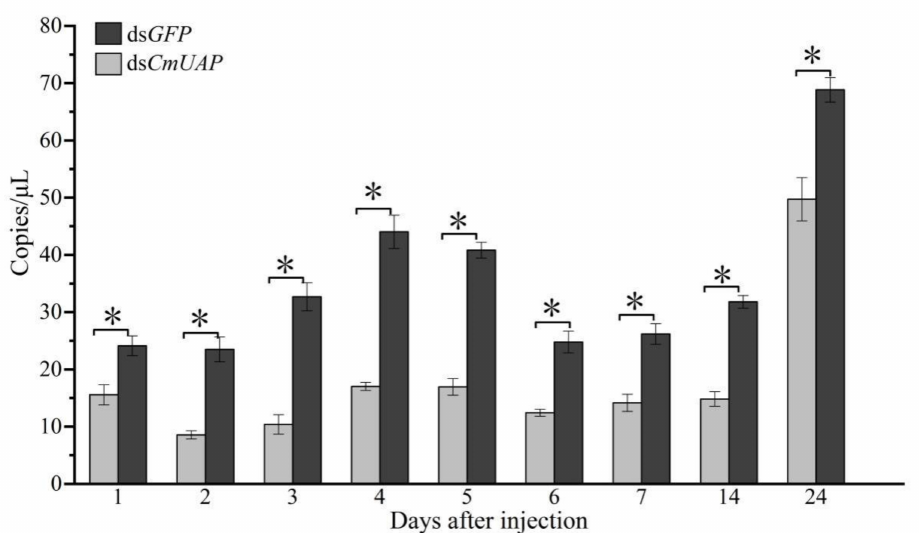
Figure 6. Expression levels of CmUAP at different times after dsRNA injection. 1–7, CmUAP expression in larvae 1–7 days post injection; 14, CmUAP expression in the pupa 14 days post injection; 24, CmUAP expression in the adult 24 days post injection. Each bar represents the mean ± SD. Asterisks above bars indicate significant differences at p < 0.05 according to Duncan’s test.